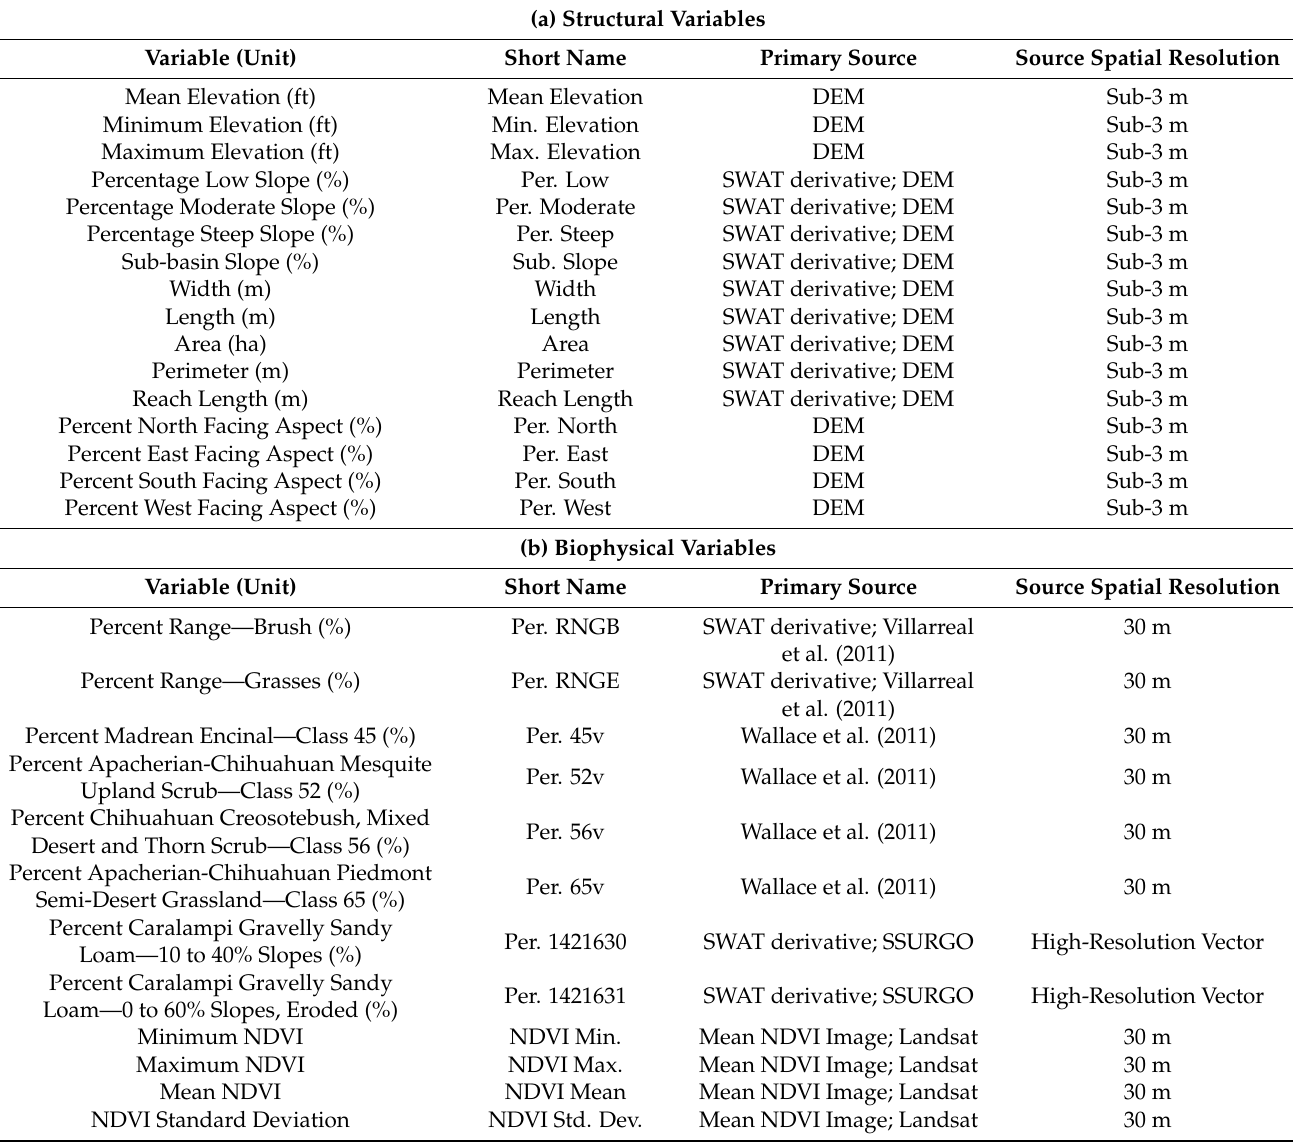
Table 2. Listing the full suite of ( a ) structural ( n = 16) and ( b ) biophysical ( n = 12) variables that were collected for each sub-basin. This list includes the unit, the short name used in the database, and the source of the variable. Per. = “percent.” Source abbreviations follow: Digital Elevation Model (DEM), Soil & Water Assessment Tool (SWAT), Soil Survey Geographic (SSURGO), and Normalized Difference Vegetation Index